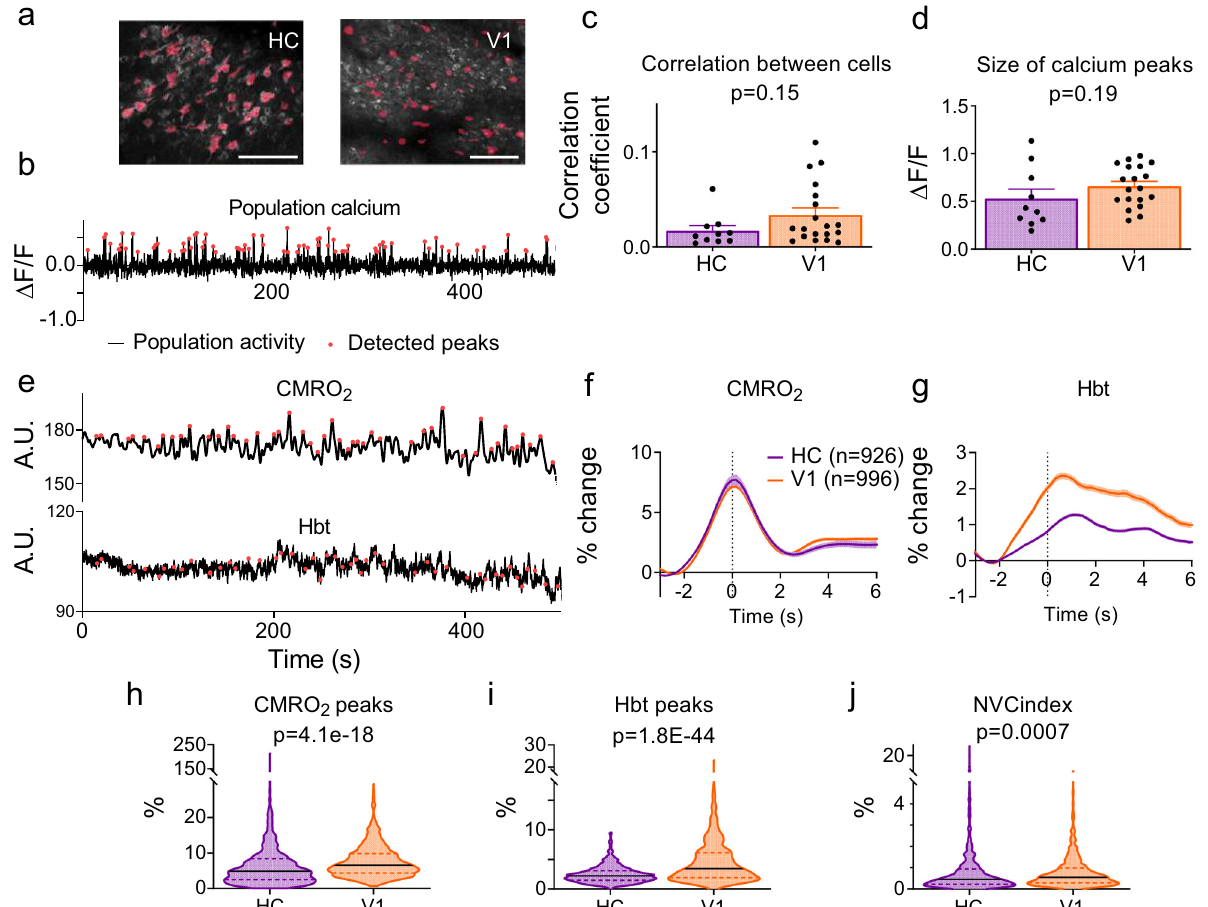
Fig. 5 Wide- fi eld neuronal activity patterns. a Representative wide fi eld-of-view recording of calcium signals (white; maximum projection across time) in HC (left, 1 of 10 independent recordings) and V1 (right, 1 of 19 independent recordings). Regions of interest (ROIs) used to measure cell activity are displayed in pink. Scale bar represents 100 μ m. b Example neuronal calcium trace, averaged across all detected ROIs. Times when net activity peaks (>2 SD above baseline mean) are shown by red dots. Neither c the correlation (Pearson ’ s R ) between individual cells within a fi eld-of-view was different, nor d the size of net calcium peaks between the HC (10 recordings from four animals, 407 cells detected in total) and V1 (19 recordings from three animals, 338 cells in total). Dots in c and d represent separate recording sessions. e Example CMRO 2 fl uctuations over time and corresponding total haemoglobin (Hbt). Detected signal peaks are marked in red. f Averaged CMRO 2 peaks per region, and g the Hbt in response to these CMRO 2 peaks (HC data represent 926 peaks taken from nine animals across 37 recordings, V1 data represent 996 peaks taken from 10 animals across 46 recordings). h The magnitude of these CMRO 2 peaks was larger in V1 than HC, and i Hbt increased more in V1 than in HC within 5 s of an increase in CMRO 2 . j The NVCindex was calculated